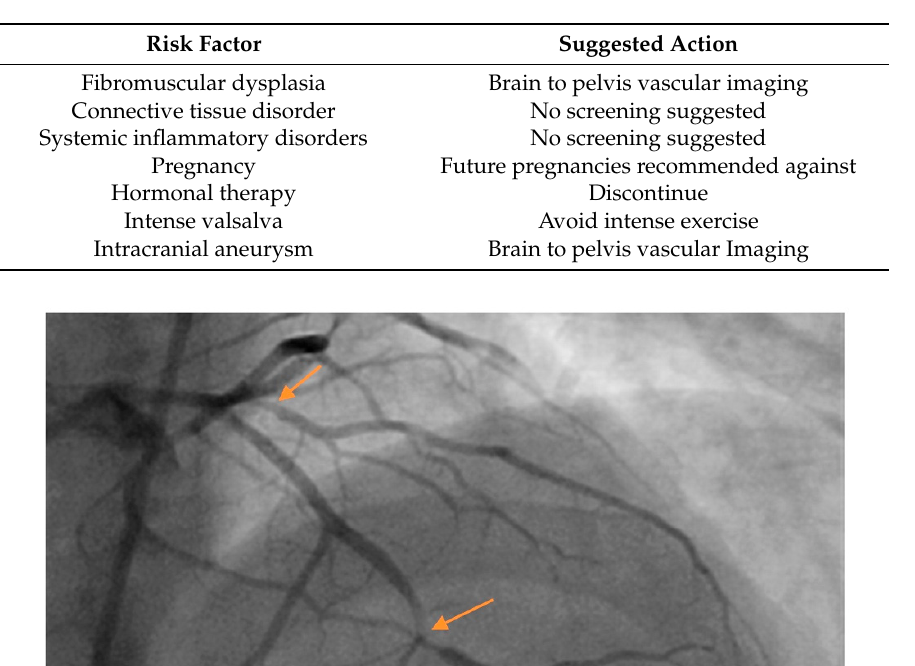
Table 2. Lists-associated conditions and suggested actions for patients presenting with SCAD.